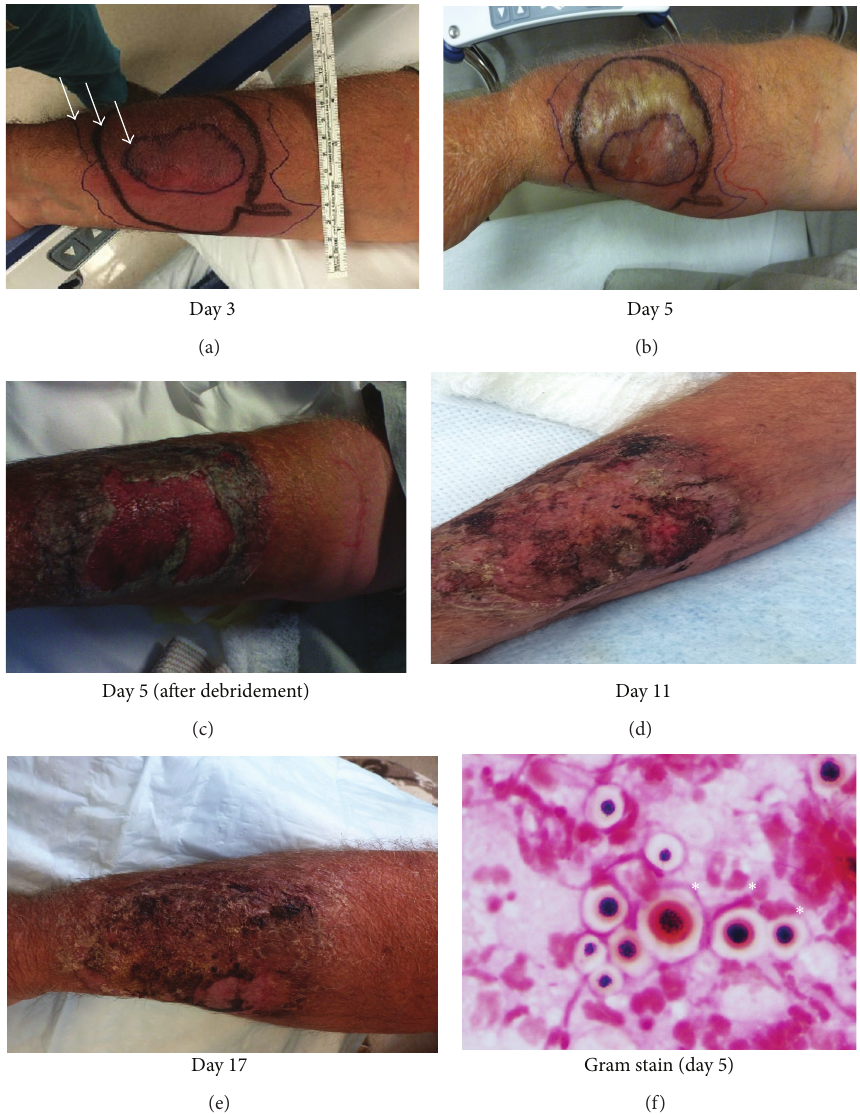
Figure 1: Primary cutaneous cryptococcosis of the right forearm. Progressive skin changes documented at the initial visit to the emergency department on the third day of symptoms (a), during hospitalization (b-c), and at postdischarge clinic follow-up (d). White arrows denote the outlines of the region of erythema marked on each respective day prior to presentation (i.e., Days 1–3). Fluconazole was initiated along with two interrupted doses of amphotericin on Day 3. Broad-spectrum antibacterial therapy with vancomycin and piperacillin-tazobactam (Day 5–Day 7), ampicillin-sulbactam (Day 8–Day 10), and amoxicillin-clavulanate (Day 11–Day 17) was also administered. (e) Wound improvement seen on one-week follow-up in clinic. The gram stain (f) from fluid expressed on Day 5 demonstrated abundant variably sized encapsulated spherical yeast forms ( ∗ ) that were identified as C. neoformans on blood